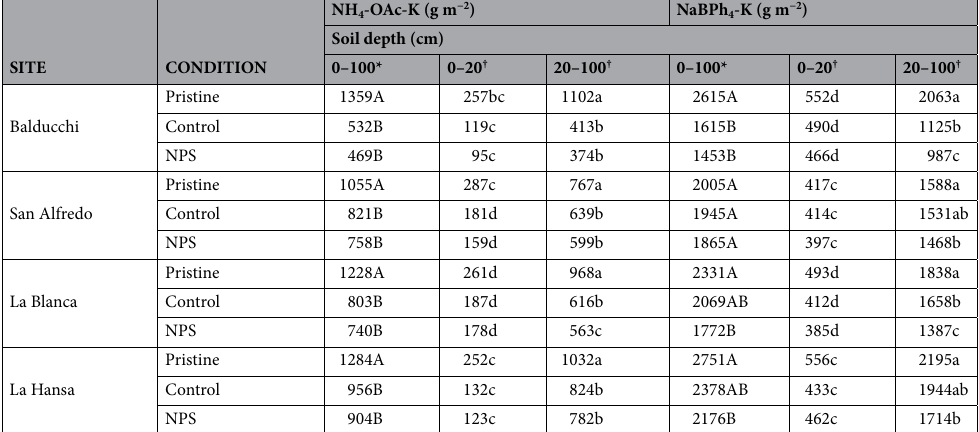
Table 2. Soil-profile K stock (g m −2 , 0–100 cm depth) for NH4-OAc-K and NaBPh4-K under different agricultural conditions (Pristine, Control and NPS) and its distribution between topsoil (0–20 cm) and subsoil (20–100 cm) layers. *Within the same site, different capital letters indicate significant differences (Tukey’s HSD, p < 0.05) among scenarios for the soil profile (0–100 cm). † Within the same site, different lowercase letters indicate significant differences (Tukey’s HSD, p < 0.05) at the interaction level (agricultural condition by soil